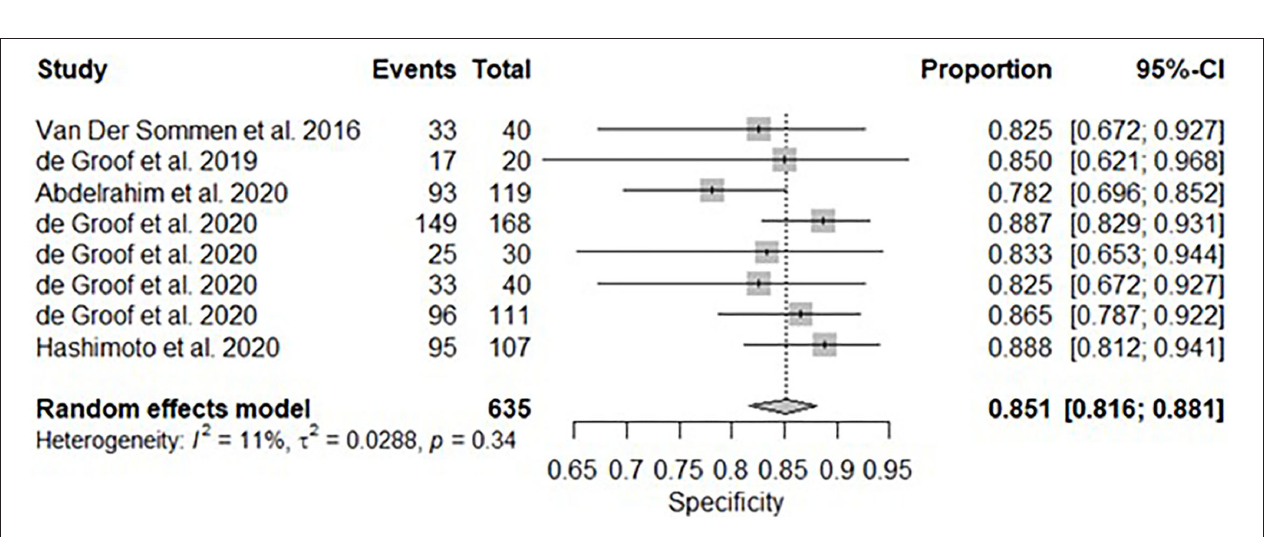
FIGURE 8 | Forest plots of pooled sensitivities for included studies of AI and the detection of early BE neoplasia (White Light Endoscopy only) – Subgroup analysis.